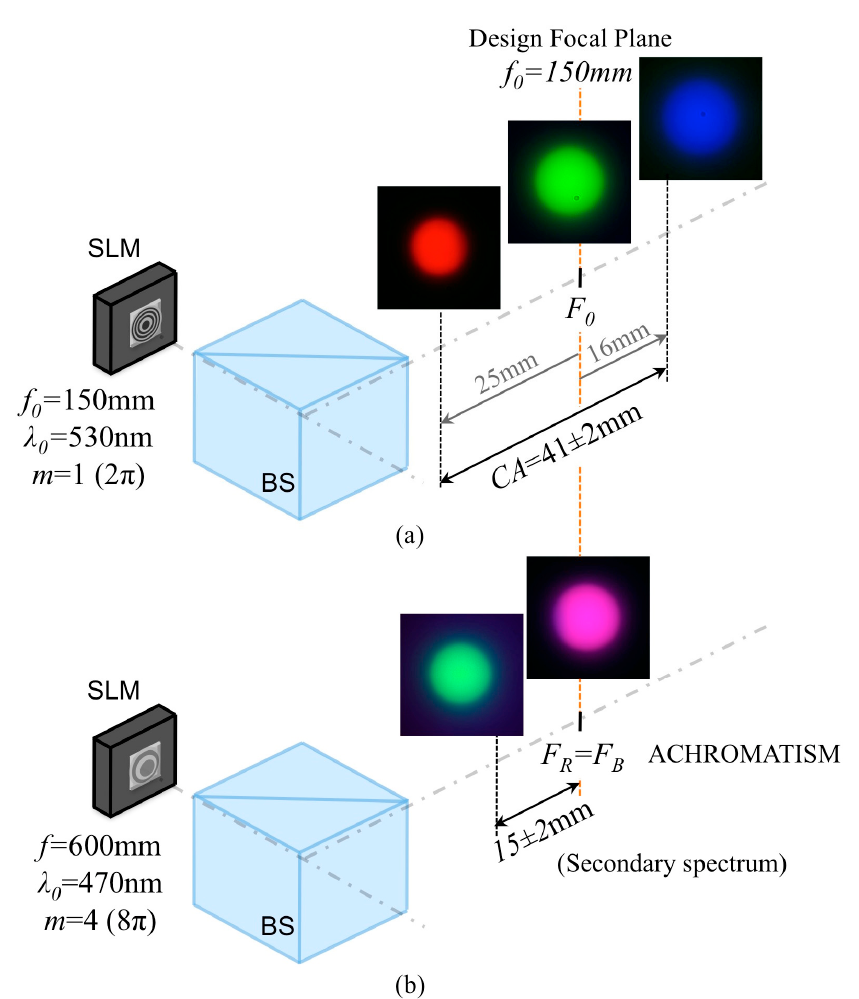
Figure 10. Experimental results for (a) Conventional modulo 2 π diffractive lens for λ 0 = 530 nm and ƒ 0 = 150 mm sequentially illuminated with three different wavelengths λ R = 625 nm, λ G = 530 nm, and λ B = 470 nm. The focalization planes with the maximum diffraction efficiencies are shown at the location where they were acquired. (b) Analogous results for a fourth-order modulo 8 π diffractive lens for λ 0 = 470 nm and ƒ = 600 mm that worked in its fourth diffraction order located at ƒ/m = 600/4 = 150 mm.